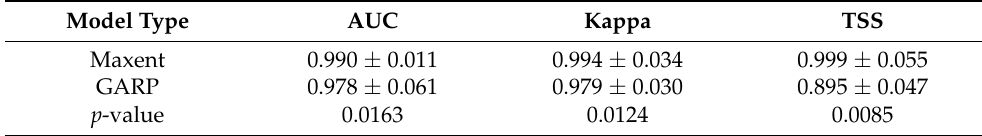
Table 2. Comparison of Area Under the Curve (AUC), Kappa, and True Skill Statistic (TSS) of Maxent and GARP models.